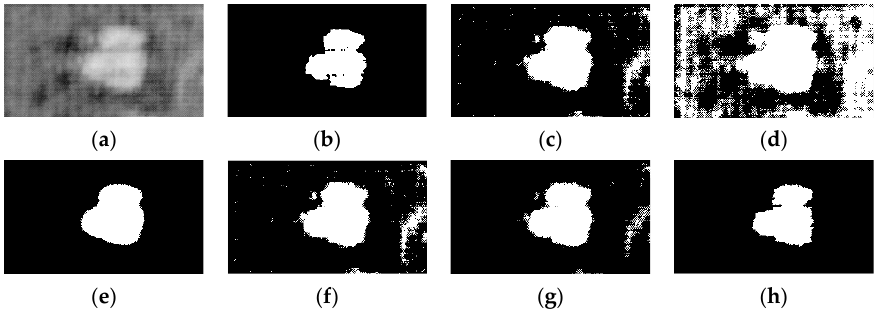
Figure 5. Image1 and its segmentation results: ( a ) #image1, ( b ) ground-truth, ( c ) Otus, ( d ) MRCUT, ( e ) EITMIS, ( f ) NSWCC, ( g ) IT2FSWCC, ( h ) FSEFTISRI.